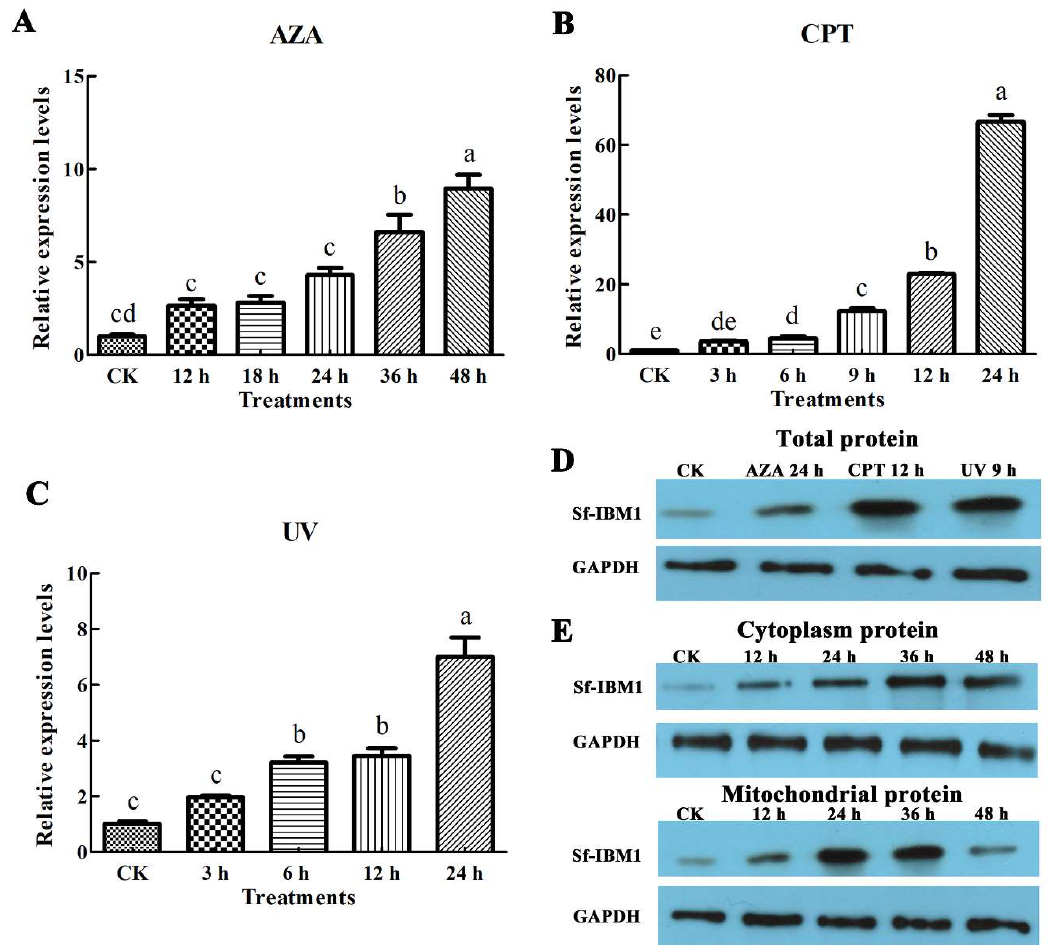
Figure 3. Apoptotic stimuli increased the expression of Sf-IBM1 in Sf9 cells. ( A ) Changes in Sf-IBM1 transcript abundance in Sf9 cells treated with 0.75 µ g / mL azadirachtin for di ff erent times. ( B )